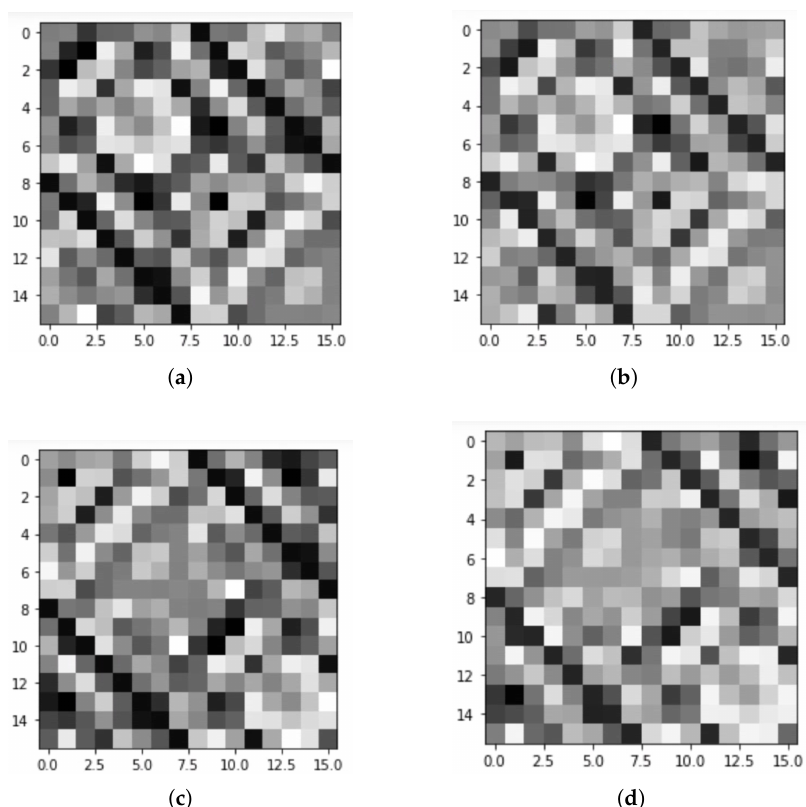
Figure 7. Visualization of real-part and imaginary-part of ground truth data and output data when there are three scatterers. ( a ) ground truth data (real-part); ( b ) output data (real-part); ( c ) ground truth data (imaginary-part); ( d ) output data